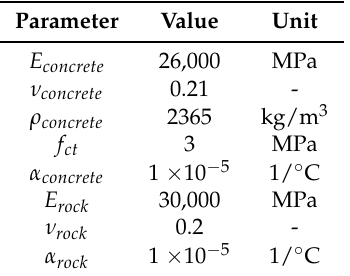
Table 1. Mechanical and thermal parameters of concrete and rock for the Beauharnois dam. Parameter Value